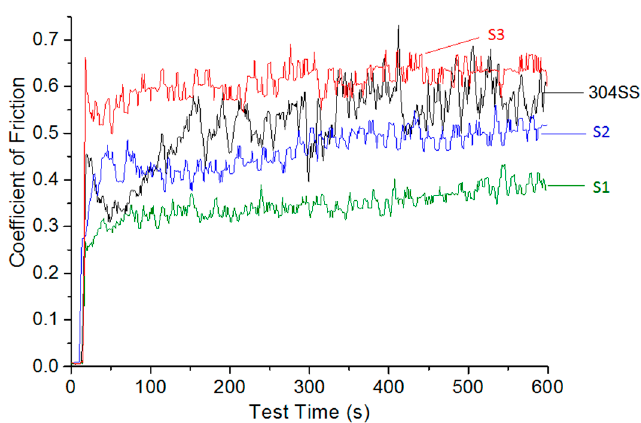
Figure 8. Evolution of the coefficient of friction curves of suspension HVOF TiO 2 coatings.